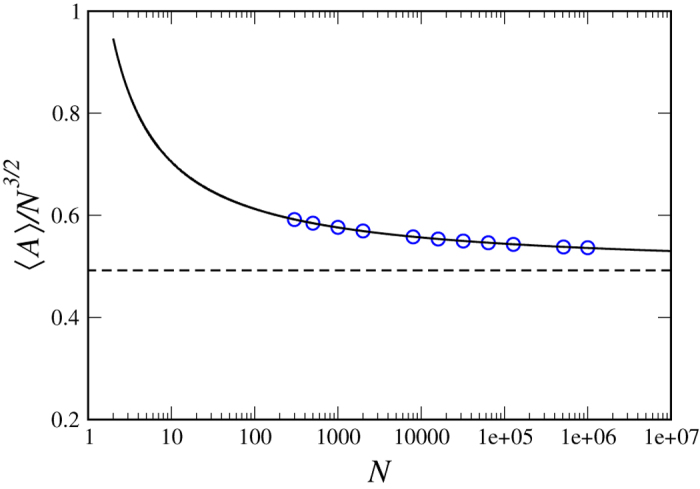
〈A〉/N3/2 as a function of N for the critical dimension d = 2: local interaction ring (LIR) model simulations (blue circles) and the fitted curve of the function: 〈A〉/N3/2 ≃ 0.497 + 0.544/log(N).The black dashed line is the theoretical value of c+ = 0.4922 for the N → ∞ limit.